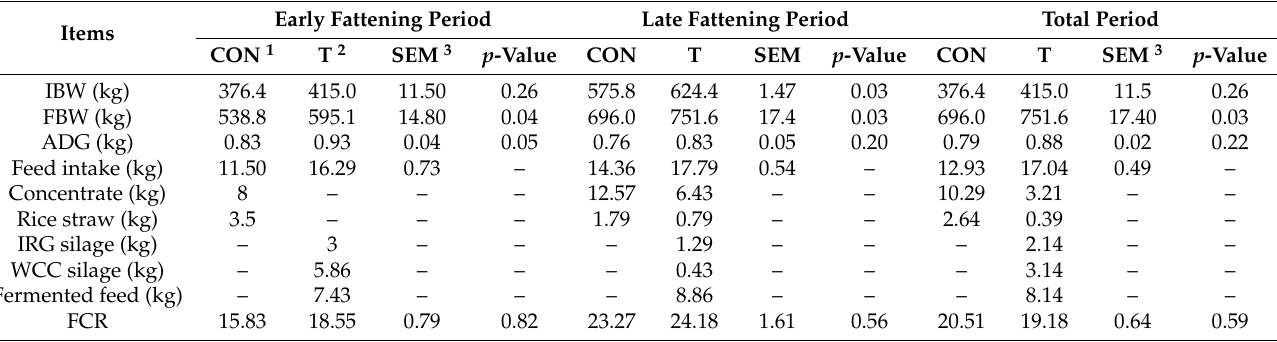
1 Control group: Hanwoo steers fed rice straw + concentrate; 2 Treatment group: Hanwoo steers fed IRG silage + WCC silage + fermented feed; IBW: Initial body weight; FBW: Final body weight; ADG: Average daily gain; IRG: Italian ryegrass; WCC: whole crop corn; FCR: Feed conversion ratio; 3 Standard error of the mean ( p